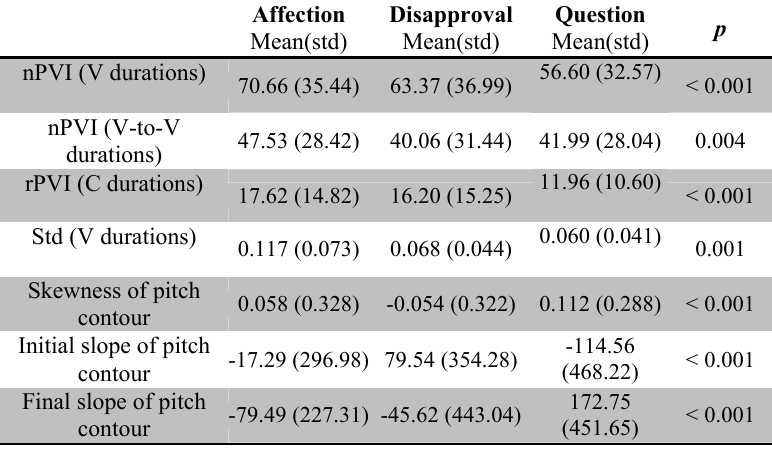
Table VIII: Mean, standard deviation and p-value for a group of features, considering affection, disapproval and question speech contexts.